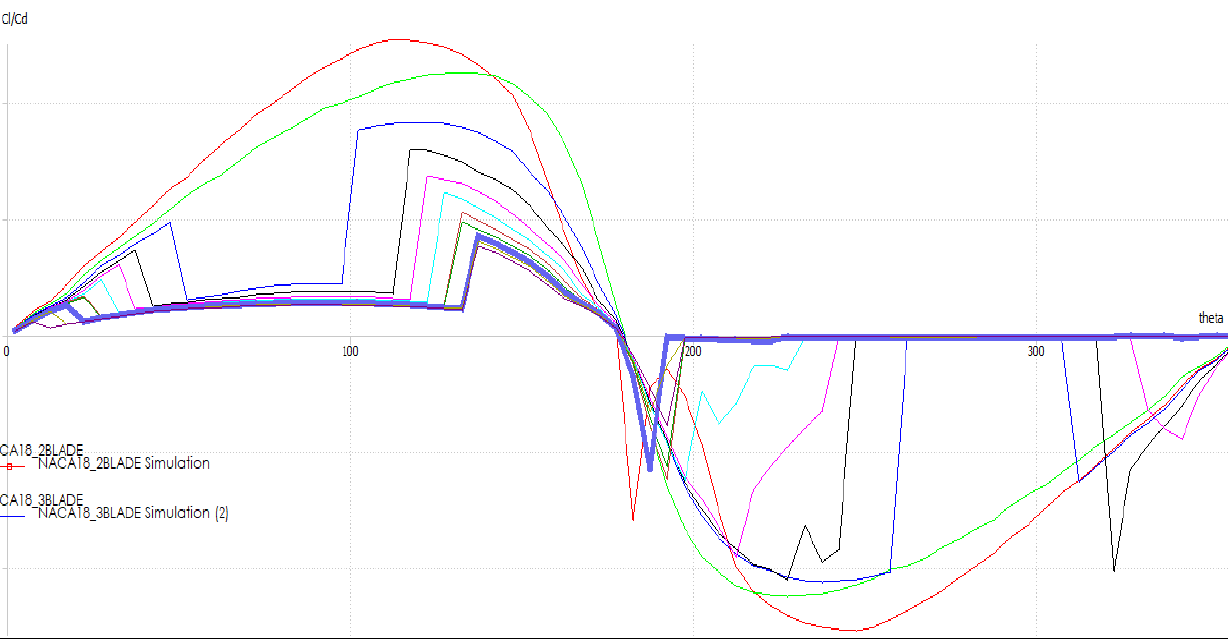
Figure 37. Cl/Cd vs theta plot of bottom-section for TSR 5